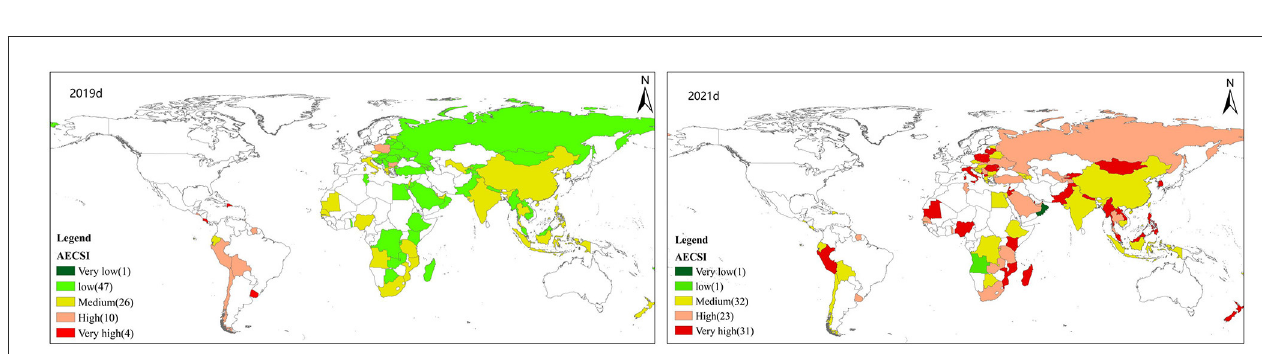
FIGURE6 Spatial pattern of Comprehensive Risk of agricultural products security risks. d, AECSI in 2019 and